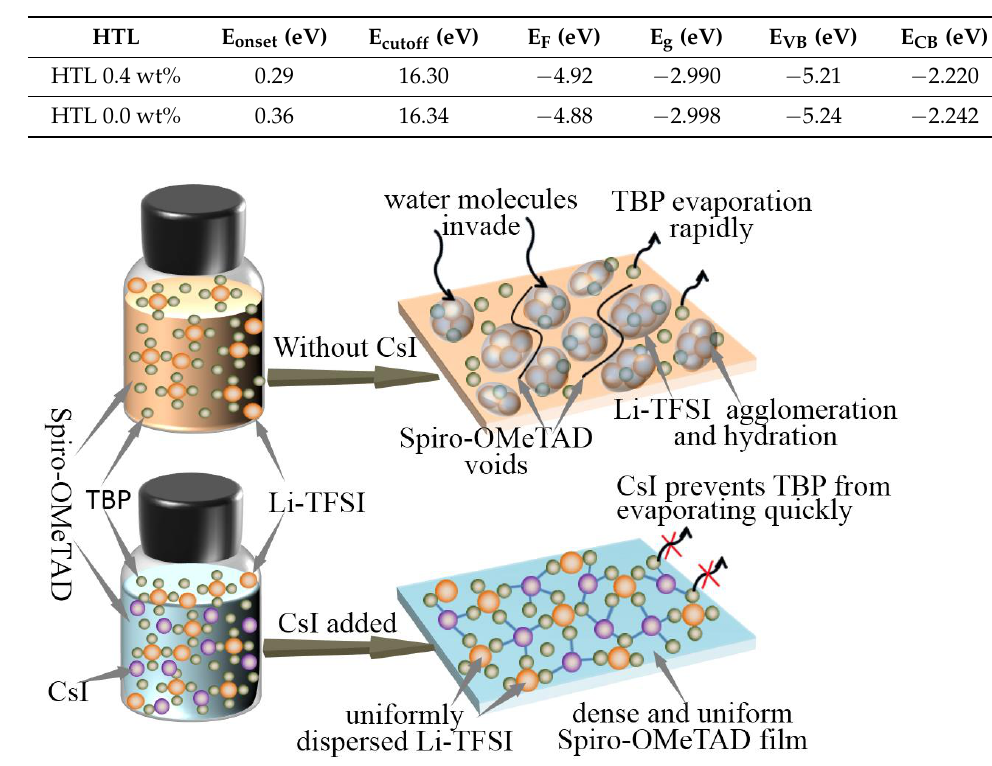
Figure 5. Schematic illustration of the effect of CsI on preventing Li-TFSI from aggregation. Crystals 2022 , 12 , x FOR PEER REVIEW